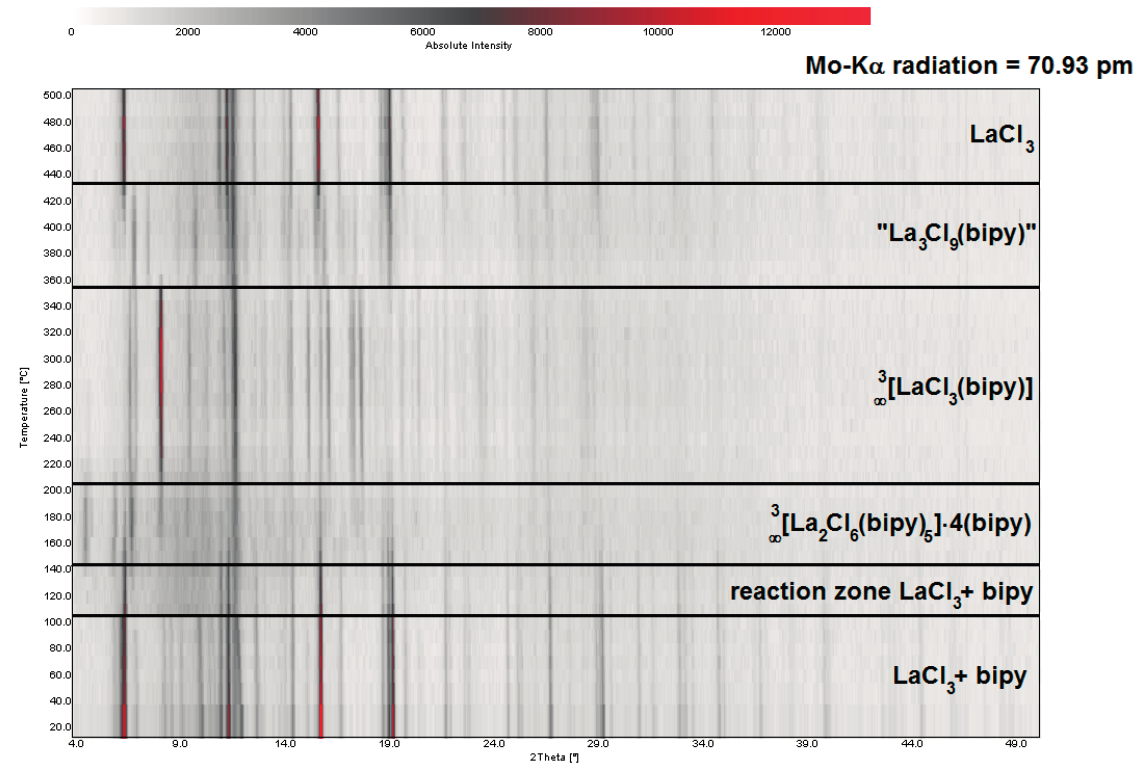
Figure 4. Depiction of temperature-dependent X-ray powder diffraction of the reaction of LaCl 3 and 4,4 ′ -bipyridine illustrating the temperature dependent formation of several crystalline coordination polymers and MOFs.